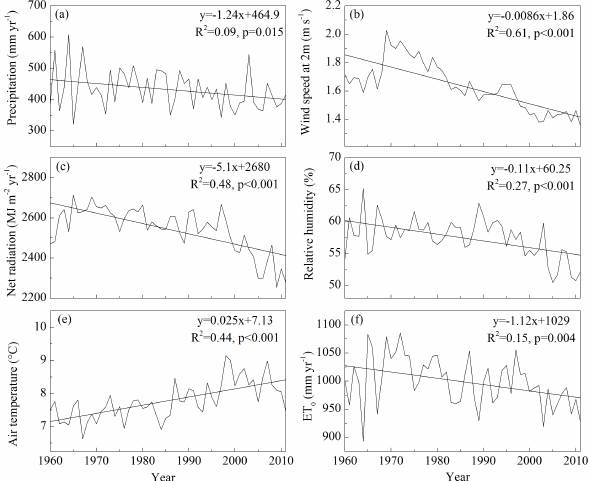
Fig. 2. Inter-annual variations in precipitation (a) , wind speed at 2m above the ground (b) , net radiation (c) , relative humidity (d) , air temperature (e) , and potential evapotranspiration (f) over the study area from 1960 to 2011.